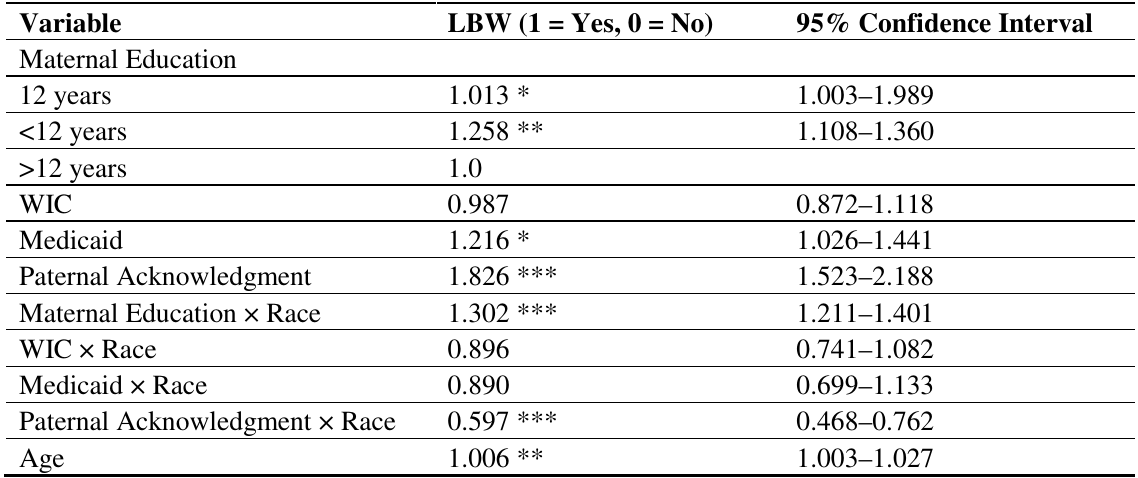
Table 3. Odds ratios for SEP measures and LBW (interaction